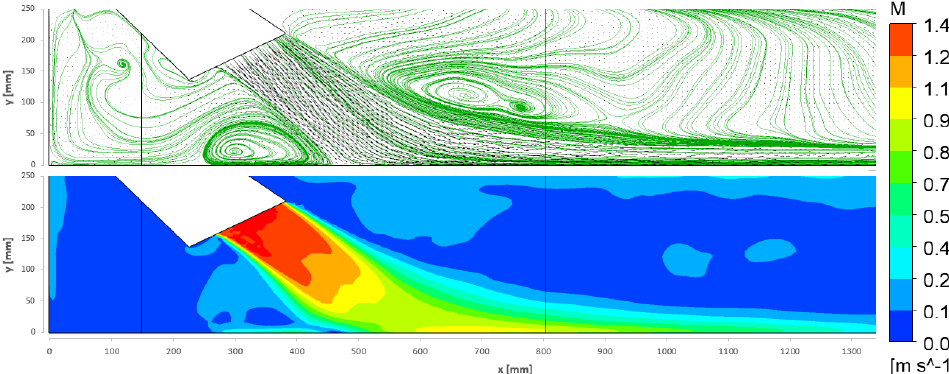
Figure 9. Finitevolume method (SAS model), vector lines ( top ) and the magnitude of time-averaged 2D velocity ( bottom ) in vertical plane ( z = 0mm ) .